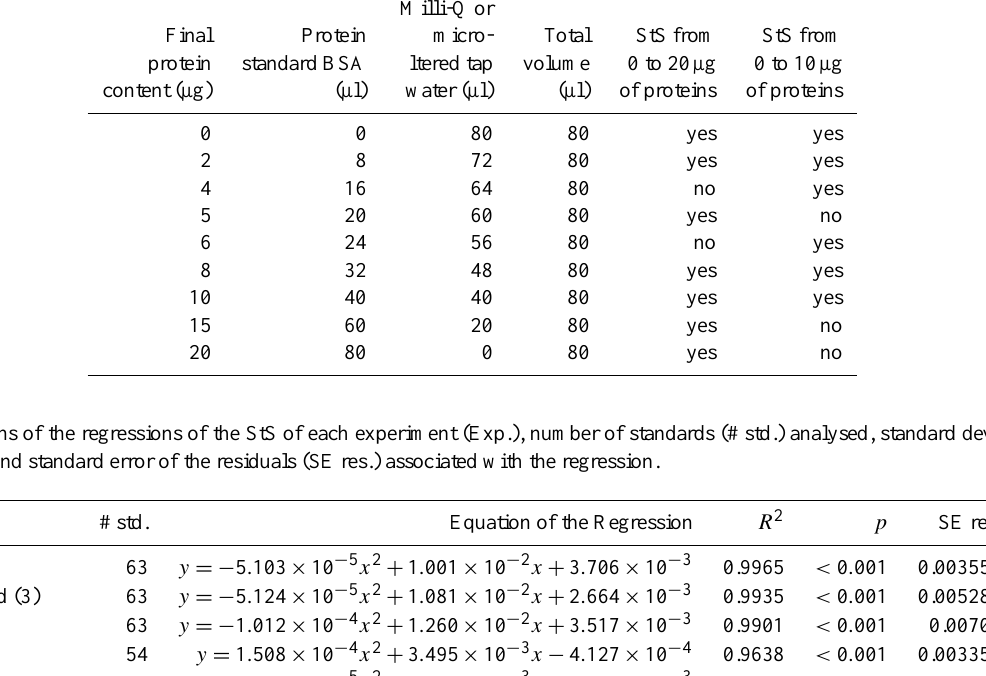
Table 2. Volumes of BSA and MilliQ- or tap water used to prepare the StS. For analyses of the specimens treated with an osmotic shock and ultrasonication, StSs of 0–20µg protein concentration were used. For NaOH treatment and for specimens sampled in November, standards of 0–10µg of protein concentration were used. Milli-Q or Final Protein micro- Total StS from StS from protein standard BSA filtered tap volume 0 to 20µg 0 to 10µg content (µg) (µl) water (µl) (µl) of proteins of proteins